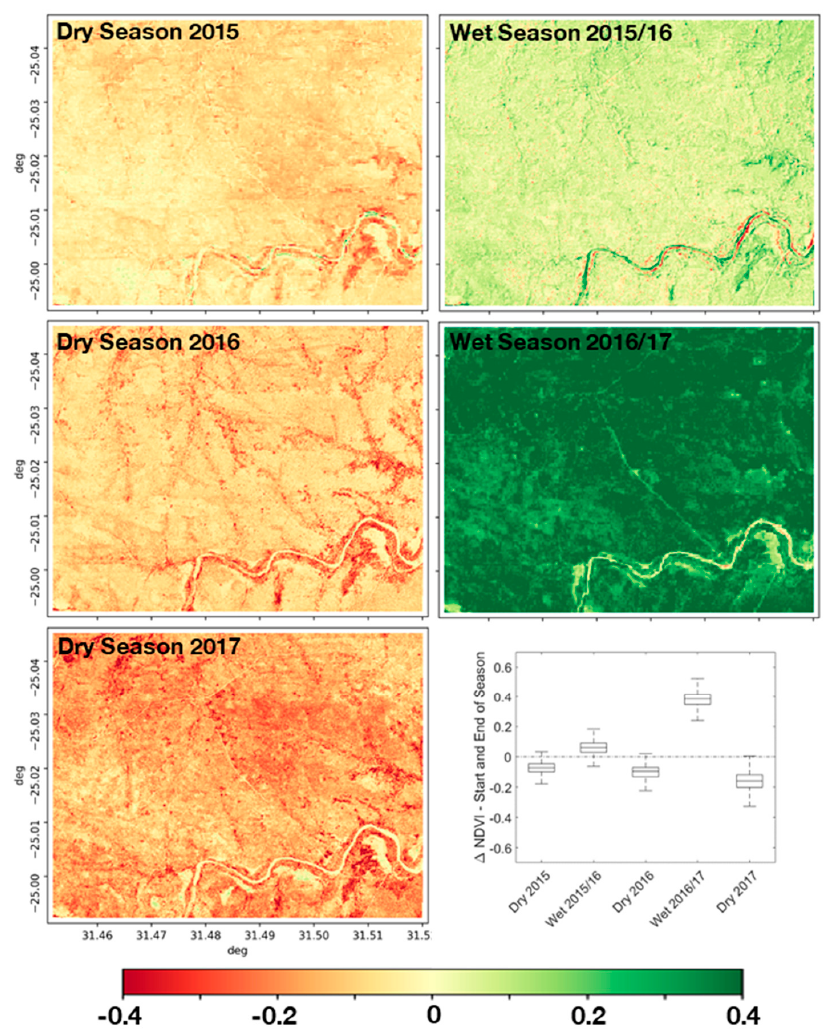
Figure 9. Overview of the ∆ NDVI representing the difference between the start and end of each wet and dry season for the entire study area.